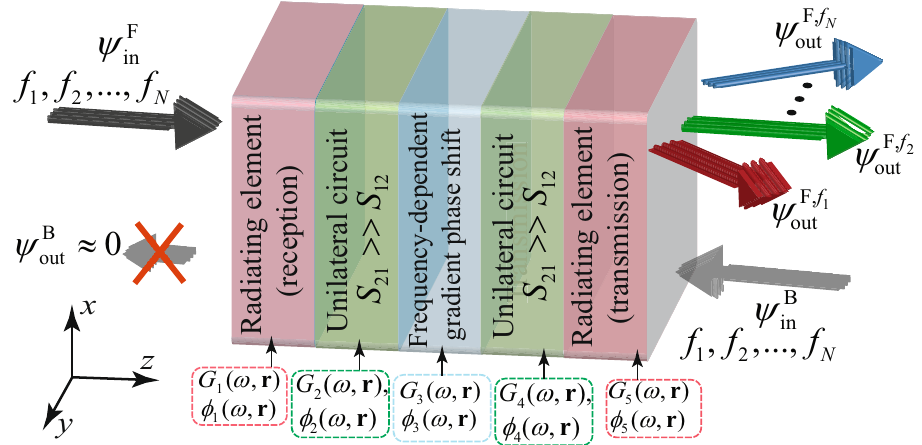
Figure 2. Composition of the programmable nonreciprocal metasurface prism. The metasurface operation is governed by a five-stage architecture, each stage proving the required transmission phase and magnitude required for a controllable and programmable nonreciprocal prism